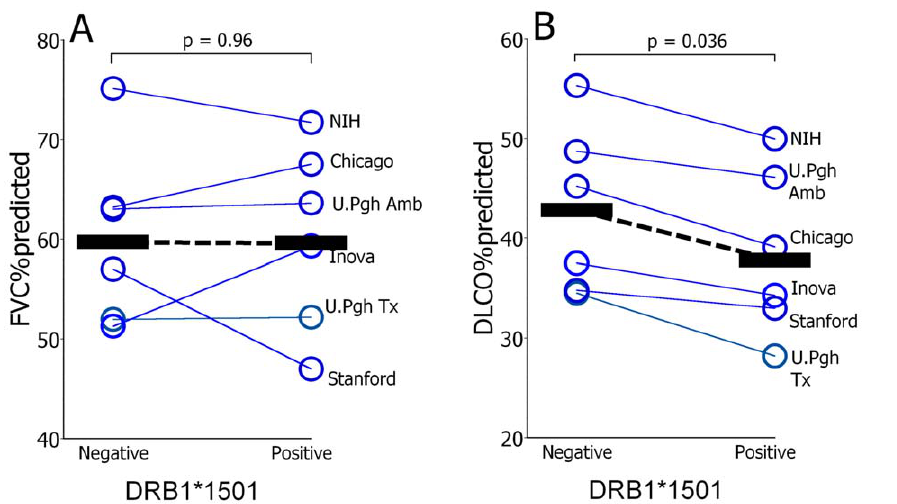
Figure 2. Associations of DRB1*1501 and lung function. A.) Forced vital capacities, as percentages of predicted normal values (FVC%predicted), did not show a consistent association with the presence or absence of DRB1*1501 among the IPF subjects. Aggregate mean values are denoted by horizontal bars linked by dashed lines. B.) Diffusing capacities, as percentages of predicted normal values (DL CO %predicted), were decreased among those IPF subjects with DRB1*1501 vs. those patients who did not have this allele, at each participating center. These differences were significant in comparisons of the cumulative (aggregate) IPF populations, despite considerable overall differences of DL CO %predicted values (e.g., ‘‘noise’’) between the various participating medical centers (see also Table 1).